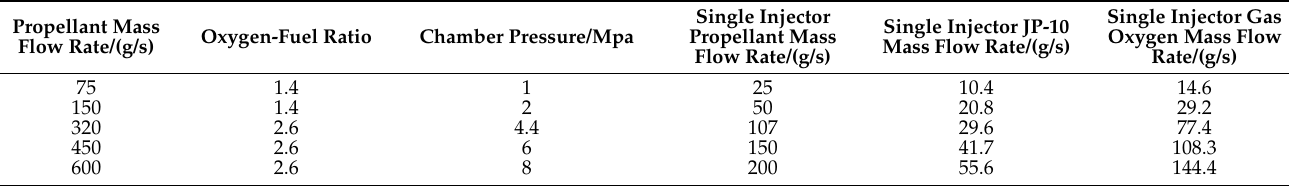
Table 1. Working condition points selection.